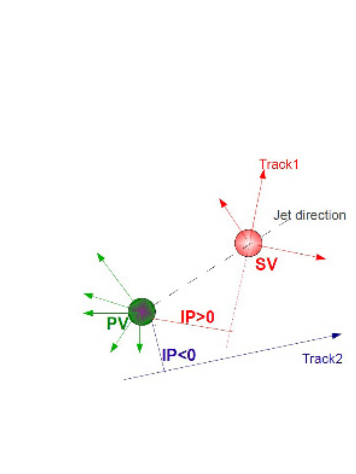
Fig. 3. Geometric meaning of the impact parameter